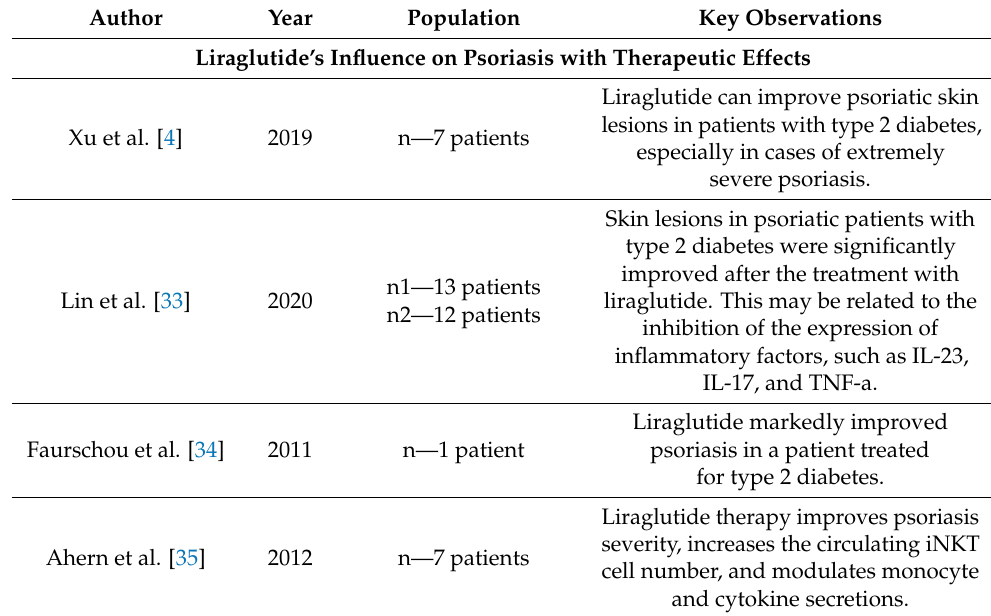
Table 13. Summary of the studies on liraglutide’s influence on psoriasis with therapeutic effects.